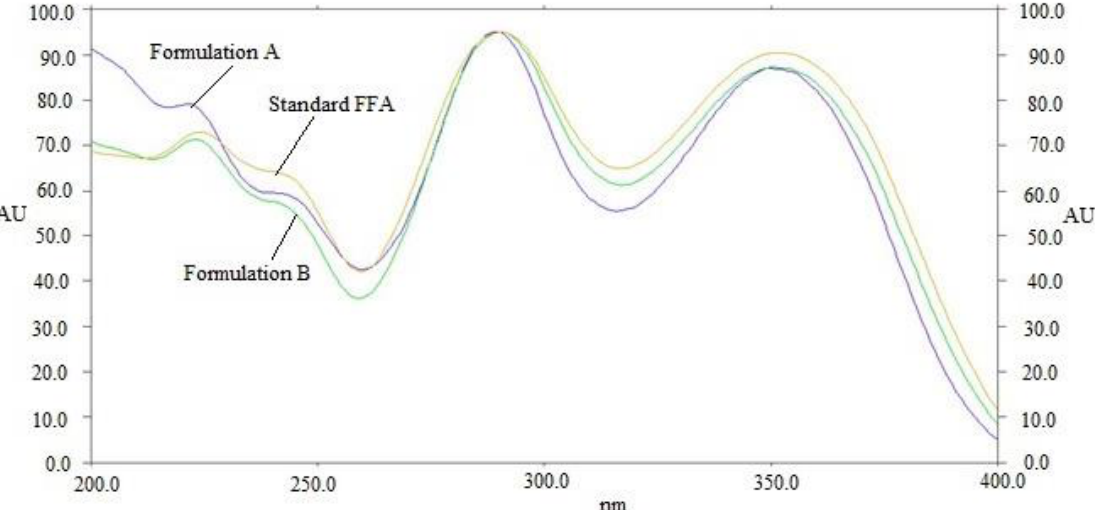
Figure 4. UV-absorption spectra of standard FFA and marketed products, superimposed.